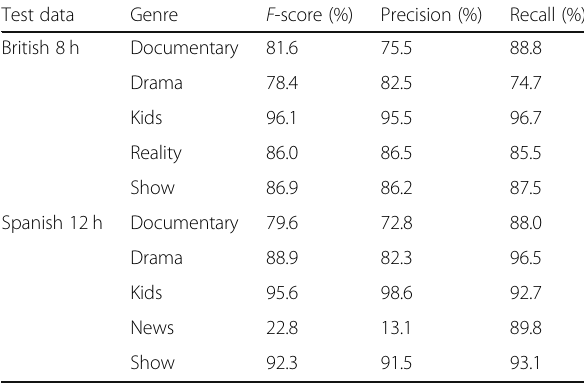
Table 4 Performance of the proposed algorithm by genre Test data